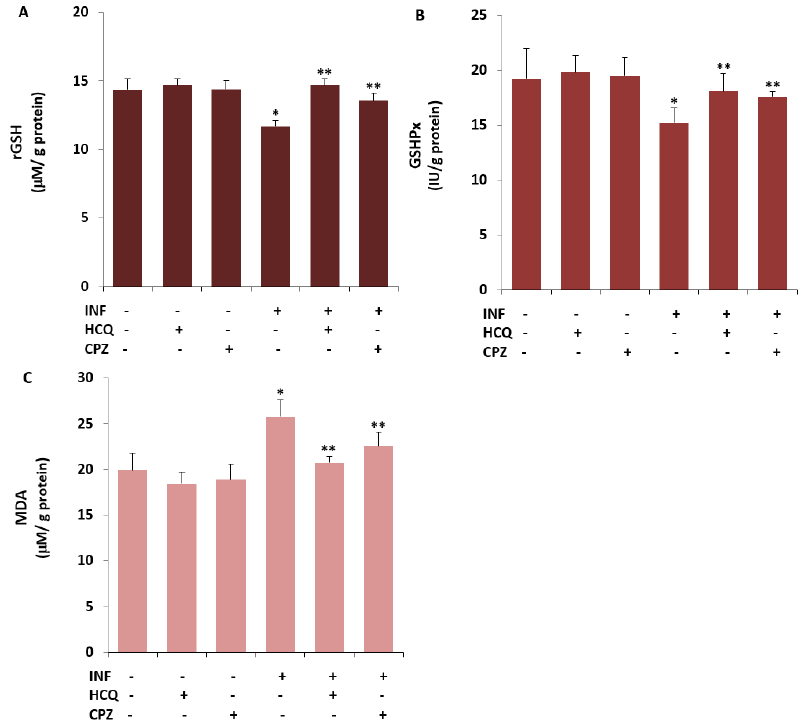
Figure 4. HCQ (60 μM) and CPZ (0.1 mM) attenuated INF-induced the increase of lipid peroxidation (MDA) in the U937 cell by the upregulation of reduced glutathione (rGSH) and glutathione peroxidase (GSHPx) (Mean ± SD and n = 6). The determinations of rGSH ( A ), GSHPx ( B ), and MDA ( C ) in the six groups were manually performed in the cells by using the spectrophotometer. (* p ≤ 0.05 vs. Cntr, HCQ, and CPZ. ** p ≤ 0.05 vs. INF).